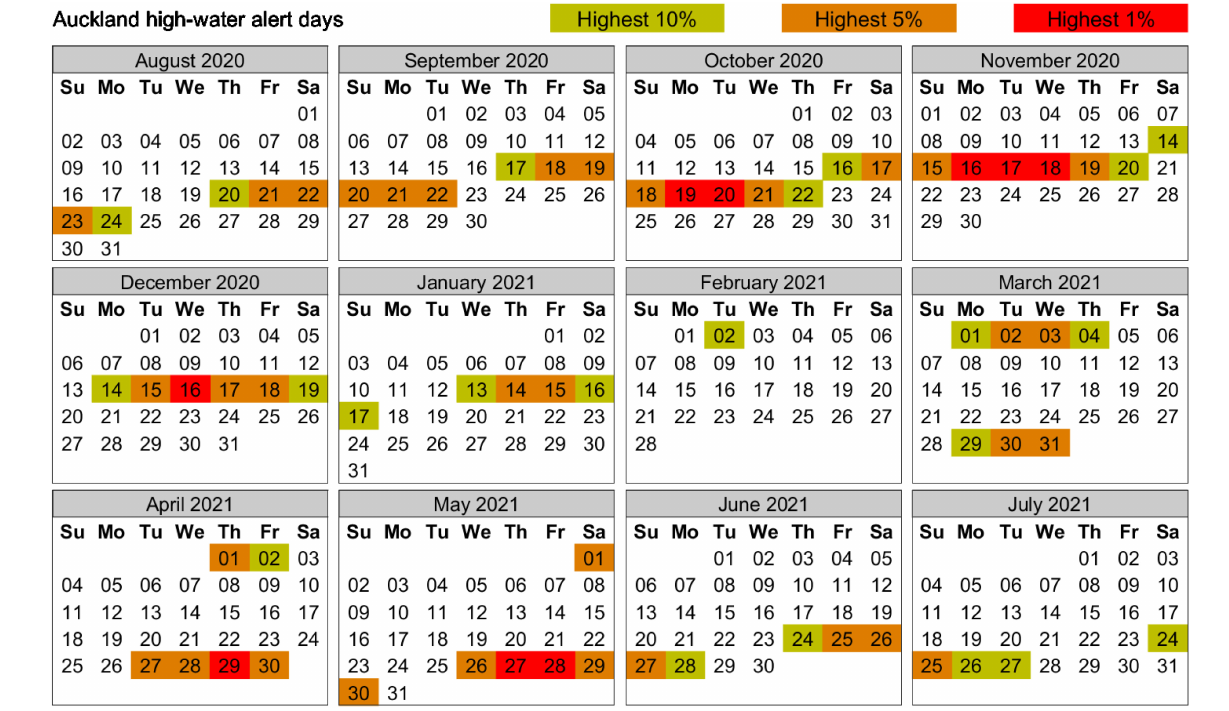
FIGURE 1 | Red-alert tide calendar at Auckland, New Zealand. Color bars above show the highest 10% (green), 5% (brown) and 1% (red) of predicted high tides for that year.